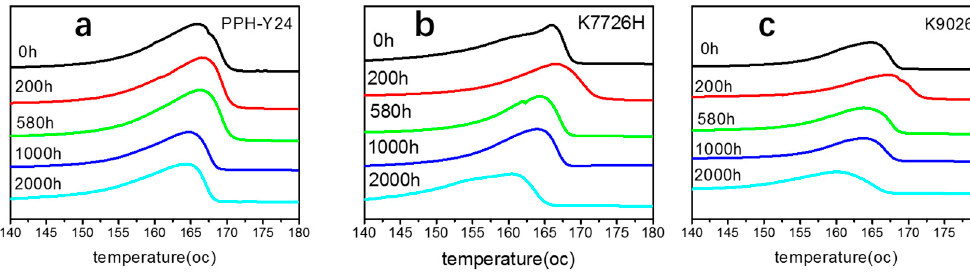
Figure 9. DSC 1 st melting thermograms of PP resins with various photoaging time. (( a ) PPH-Y24; ( b ) K7726H; ( c ), K9026; heat flow endo up).